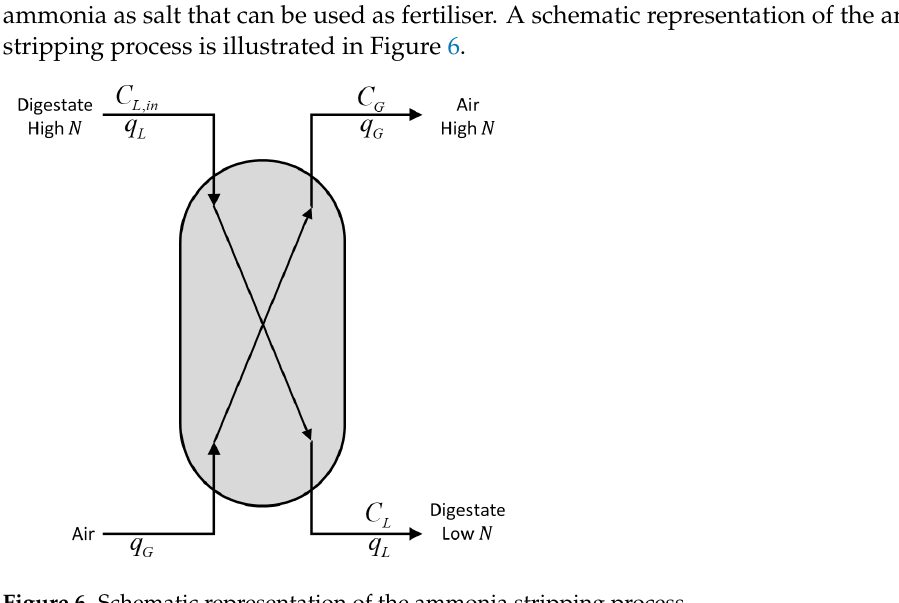
Figure 6. Schematic representation of the ammonia stripping